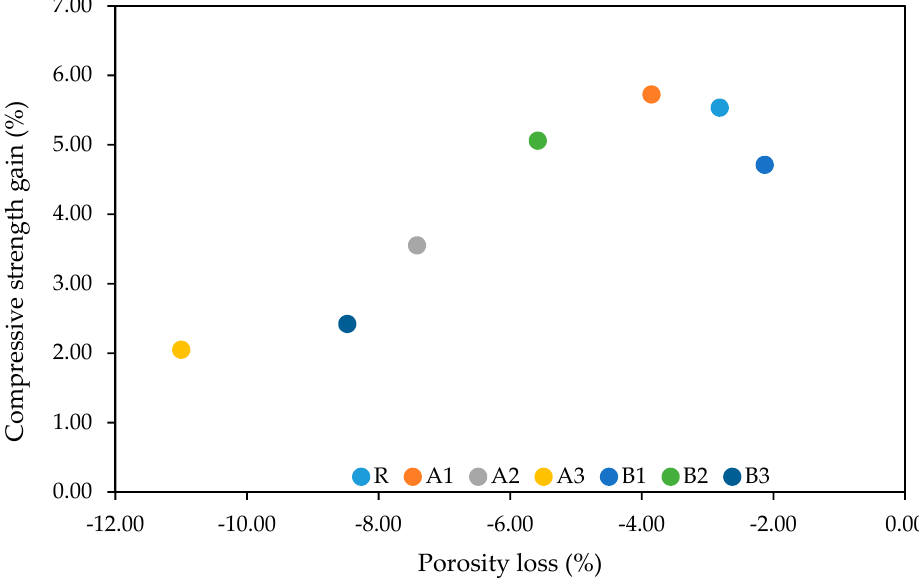
Figure 12. Relationship between porosity loss and compressive strength gain.